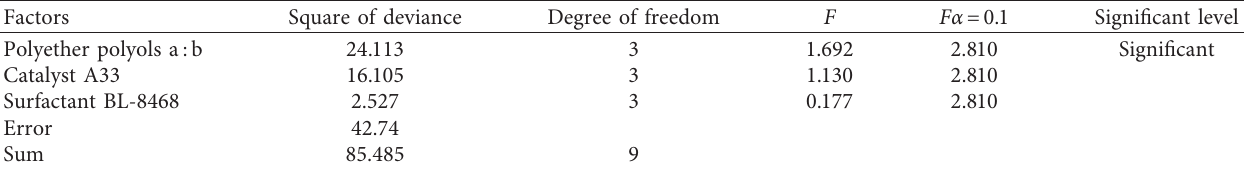
Table 8: Results of variance analysis of compressive